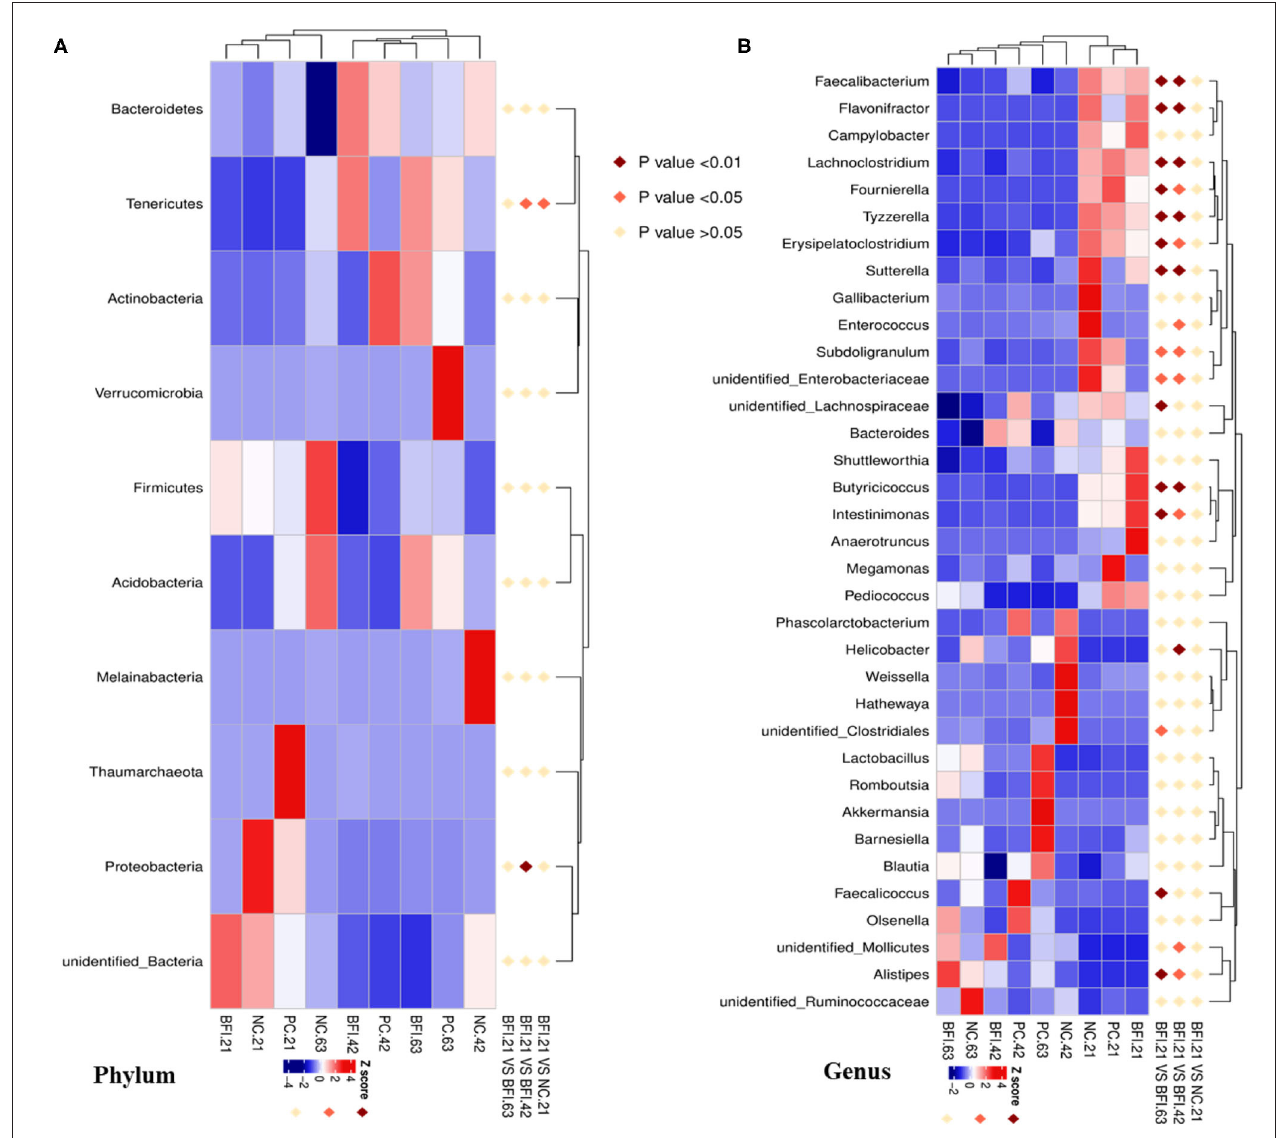
FIGURE 5 | The Metastat analysis of cecal microbiota changes in yellow-feathered broilers fed with heat-inactivated compound probiotics. The MetaStat analysis revealed the dynamic changes of differential bacterial at the phylum (A) and genus level (B) in BFI group when fed with heat-inactivated compound probiotics for different periods. Z score marked in red and blue representing significant increase and decrease of the relative abundance of specific bacterial, respectively. NC, negative control without in-feed antibiotics. PC, positive control with in-feed antibiotics with 200 mg/kg of oxytetracycline calcium + 250 mg/kg of nasiheptide. BFI, compound probiotics consisting of heat-inactivated Bacillus subtilis and Lactobacillus acidophilus